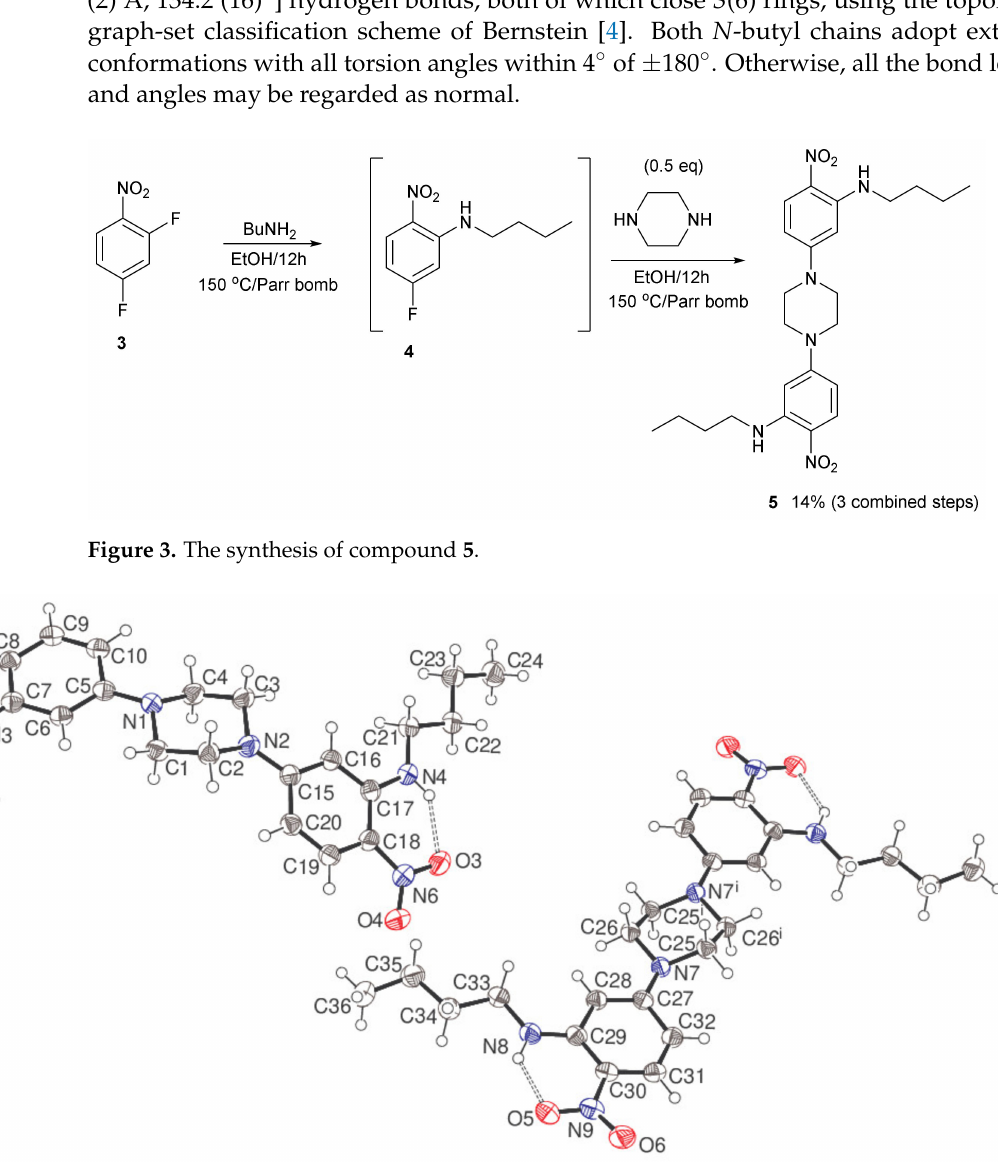
Figure 4. The molecular structure of compound 5 showing 50% displacement ellipsoids. The intramolecular N—H ... O hydrogen bonds are indicated by double-dashed lines. Symmetry code: (i) 1– x , – y , – z